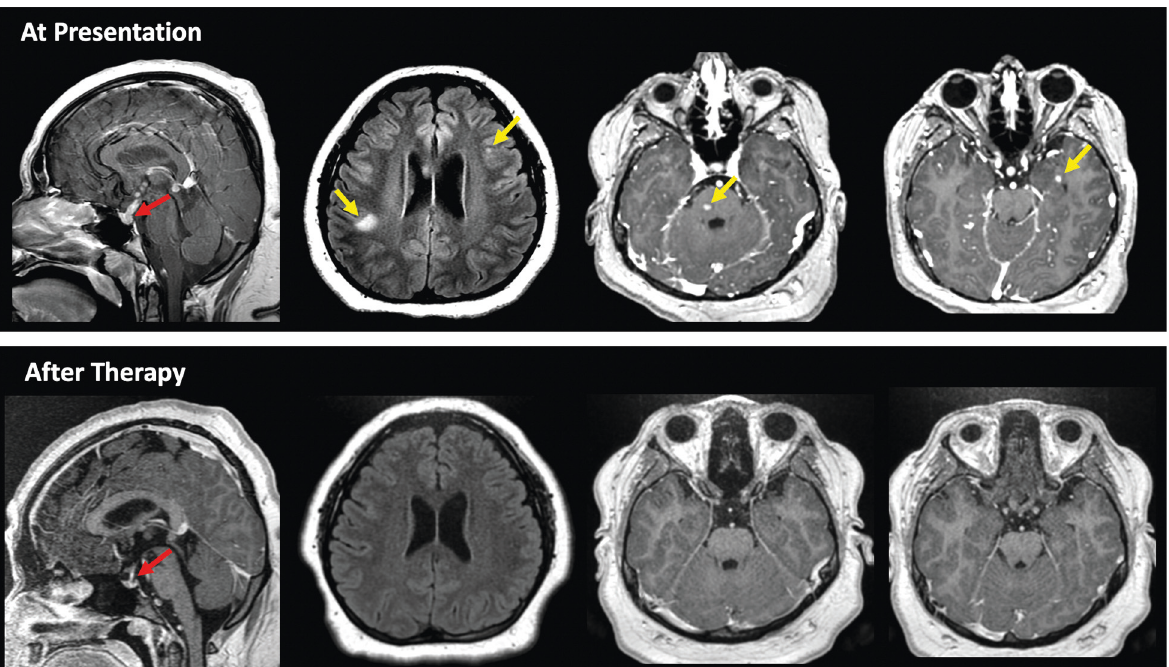
Figure 2: XD response to 2CdA on neuroimaging. MRI brain at presentation and comparison imaging after six cycles of 2CdA. Abnormal soft tissue at the pituitary stalk and extending into pituitary tissue has resolved after therapy (red arrows). Note that additional lesions in the supratentorial brain (yellow arrows) have also resolved after therapy.